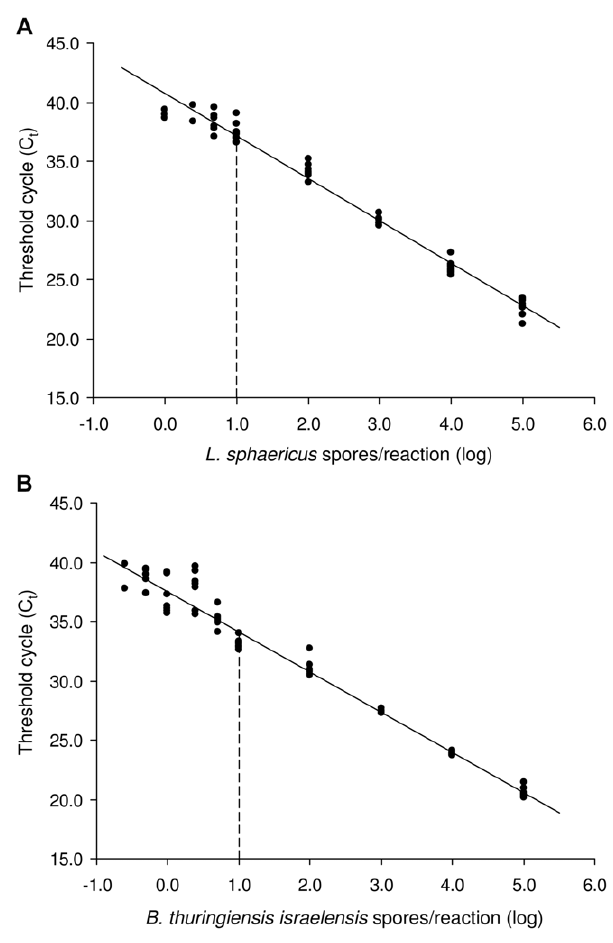
Figure 1. Standard curves for the quantification of Lysinibacillus sphaericus (A) and Bacillusthuringiensisisraelensis (B). Each spore concentration was tested with 9 replicates on 3 different runs. Linear regressions, Lsph: y= 3.59x + 40.71, R 2 =0.98; Bti: y= 3.39x + 37.50, R 2 =0.97. The dashed line represents the LOQ of the real-time PCR assay.